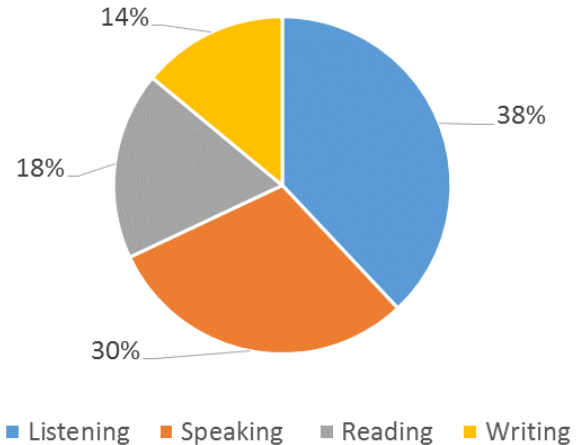
Figure 8: The relevance of certain speech activities for learning through mobile